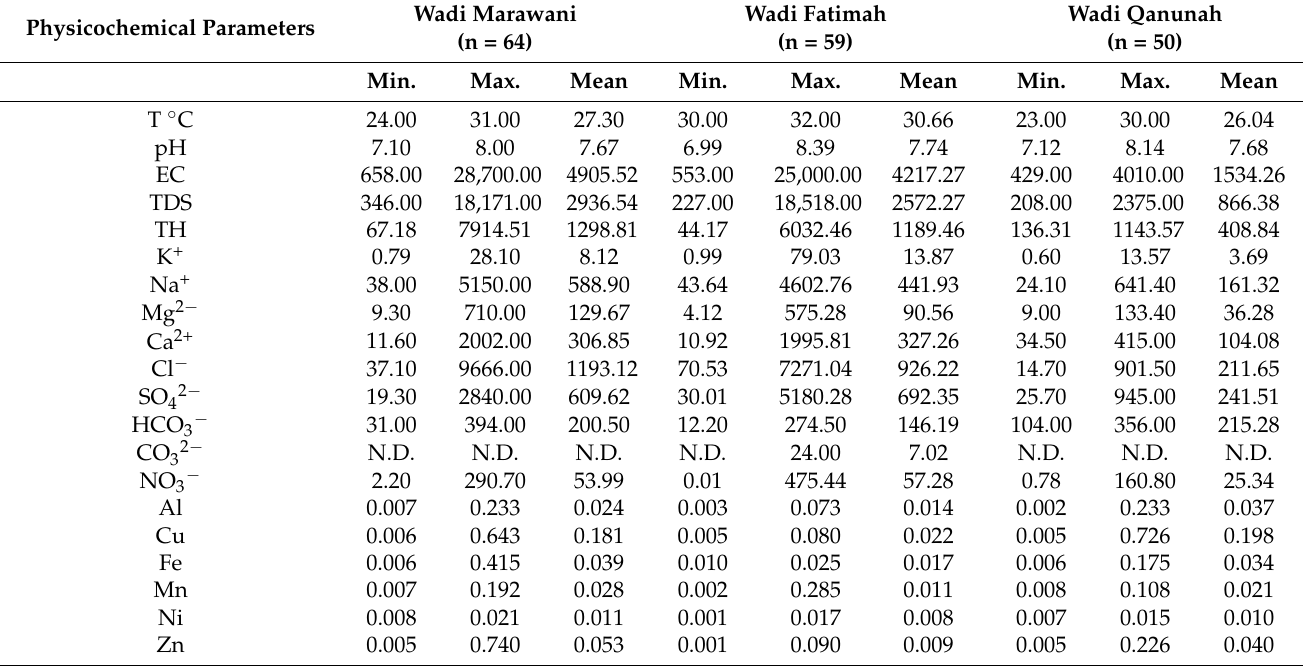
Table 5. Statistical analysis of the physical and chemical parameters of groundwater samples in the three selected wadies, Makkah Al-Mukarramah